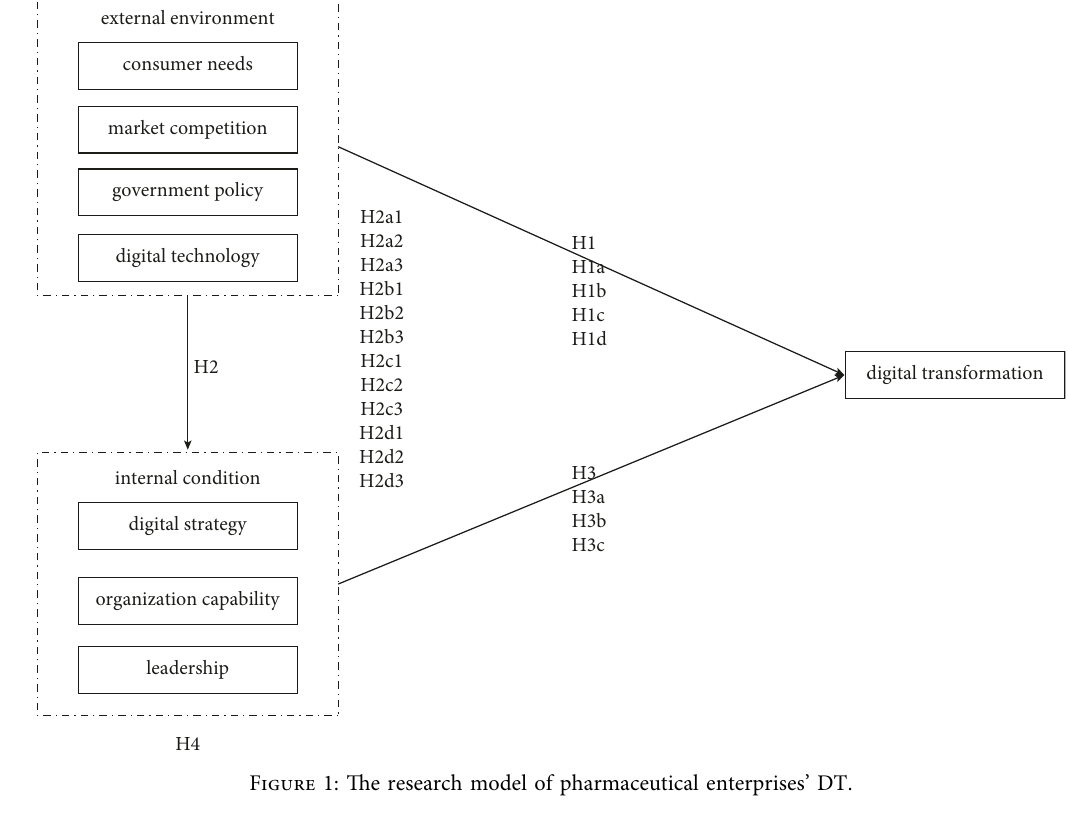
Figure 1: The research model of pharmaceutical enterprises’